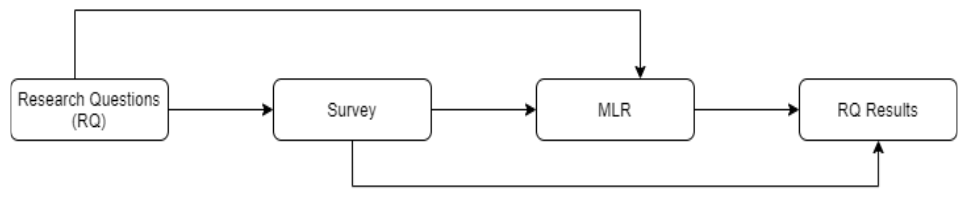
Figure 2. Research